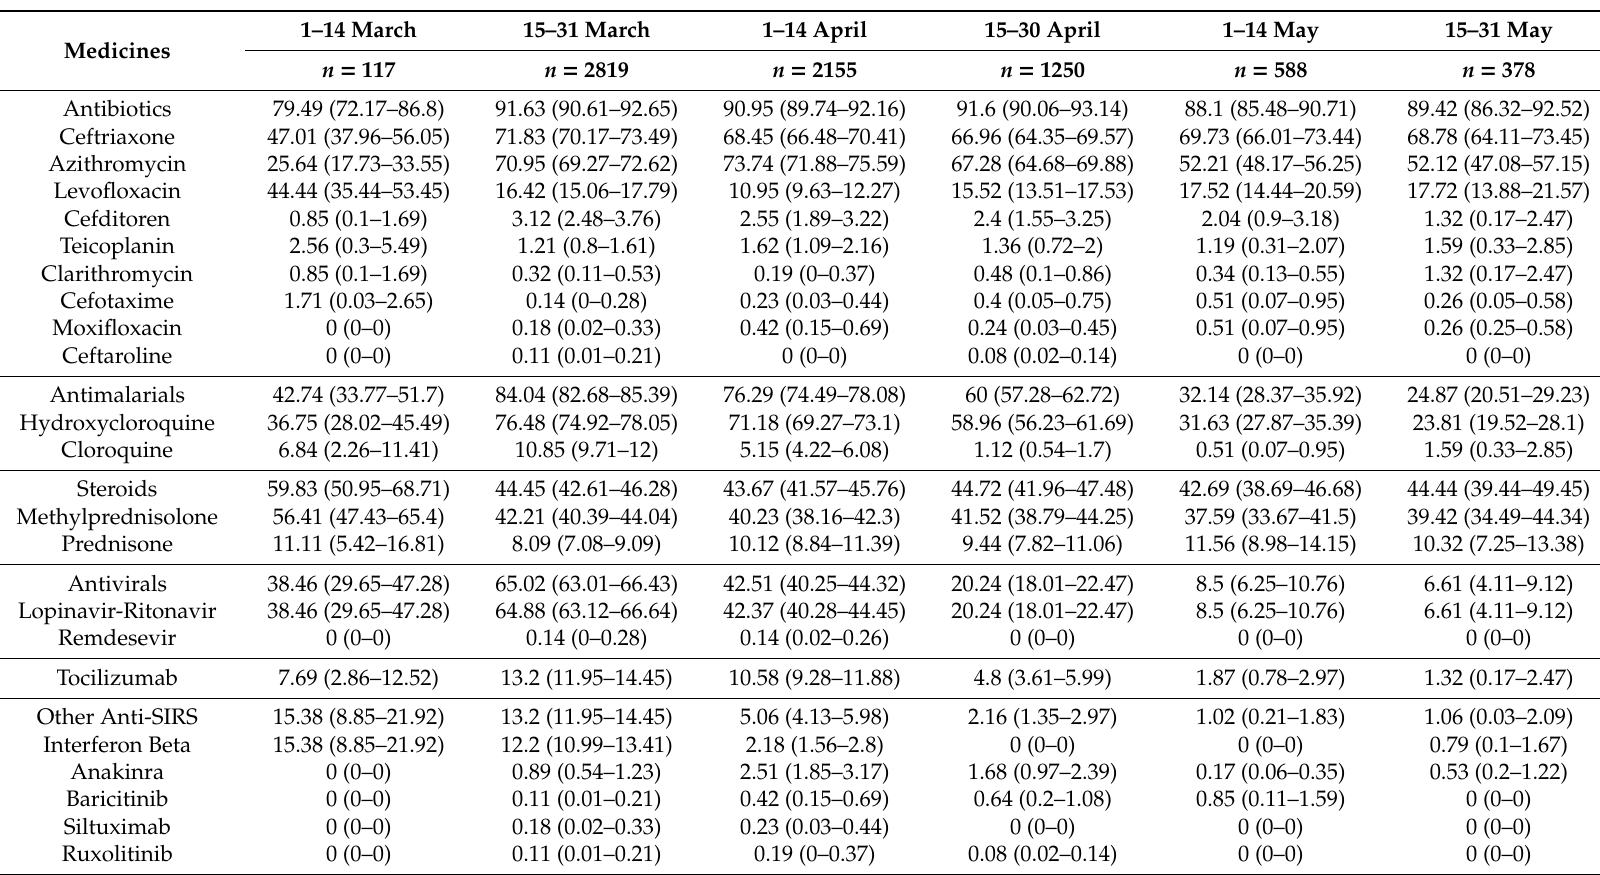
Table 2. Biweekly therapy evolution in the hospitalized COVID-19 patients in Castile and Leon (Spain) during the first wave (1 March to 31 May 2020).